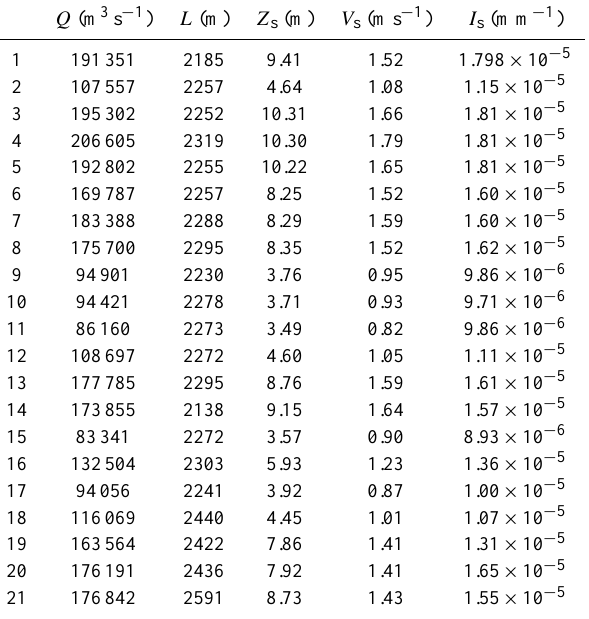
Table 2. Set of measurements at the Obidos gauging station.